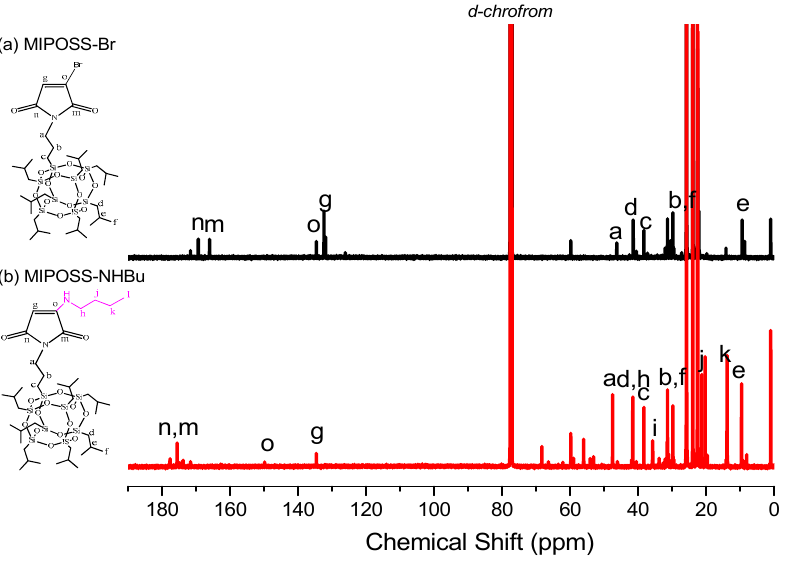
Figure 2. 13 C-NMR spectra of the monomers: ( a ) MIPOSS-Br; and ( b ) MIPOSS-NHBu. Poly(S-alt-MIPOSS-Br), Poly(S-alt-MIPOSS-NHBu), and Poly(AS-alt-MIPOSS-NHBu) Alternating Copolymers. A solution of MIPOSS-Br (0.50 g, 0.50 mmol) or MIPOSS-NHBu (0.40 g, 0.077 mmol), styrene (0.33 g, 3.16 mmol) or 4-acetoxystyrene (0.52 g, 3.17 mmol), and AIBN (5 wt %) were dissolved